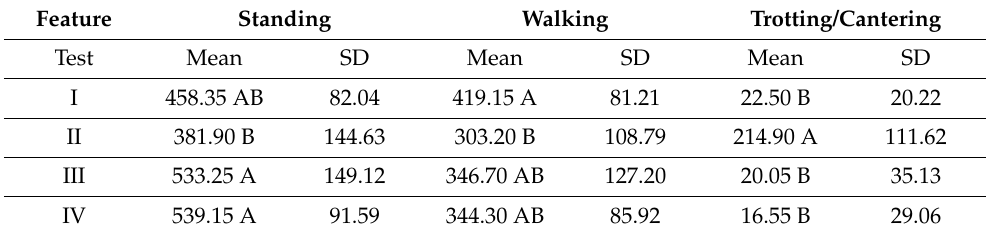
Table 3. Locomotor features in consecutive